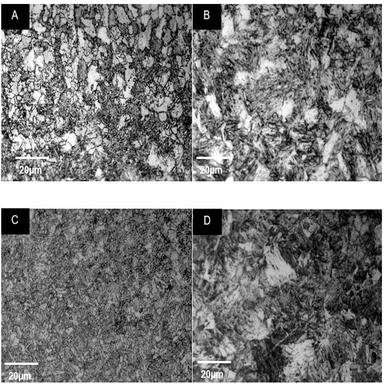
Metallurgical analysis of the microstructures produced (A) deposition speed 3 mm/s and 30 second hold-off resulting in a ferrite martensite structure (B) deposition speed 3 mm/s and 50 second hold-off resulting in a coarser ferrite-martensitic structure (C) deposition speed 4 mm/s and 3 second hold-off resulting in a martensitic structure and (D) deposition speed 4 mm/s and 5 second hold-off resulting in a coarse martensite structure.